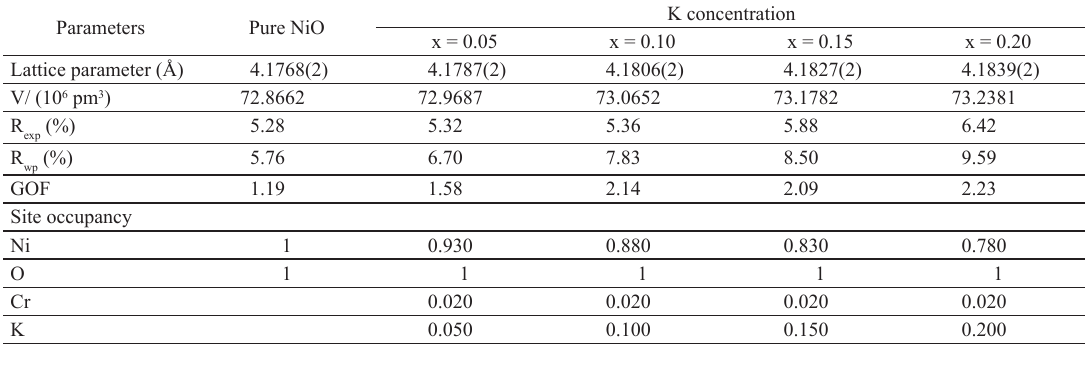
Table 1. The structural refined parameter (a), lattice volume (V), expected weighted profile factor (R goodness of fit (GOF) and site occupancy of pure NiO and samples with various K contents. Parameters Pure NiO